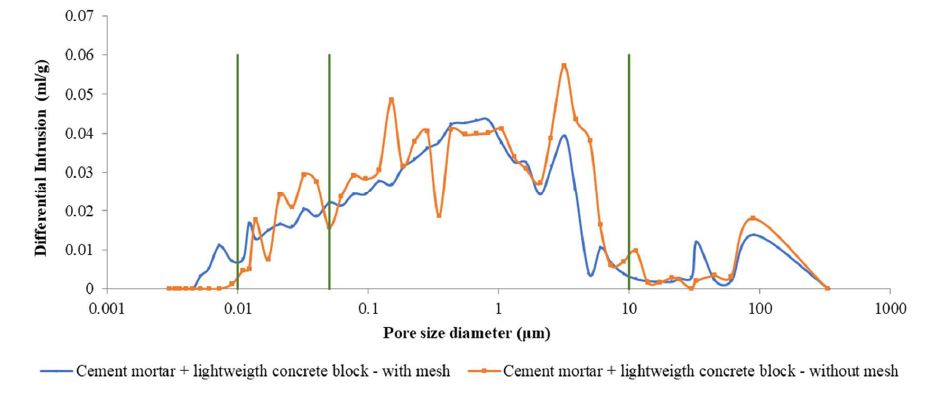
Figure 6. Porosimetry properties obtained by mercury intrusion of cement mortar applied to con- crete slab substrate, with and without mesh.